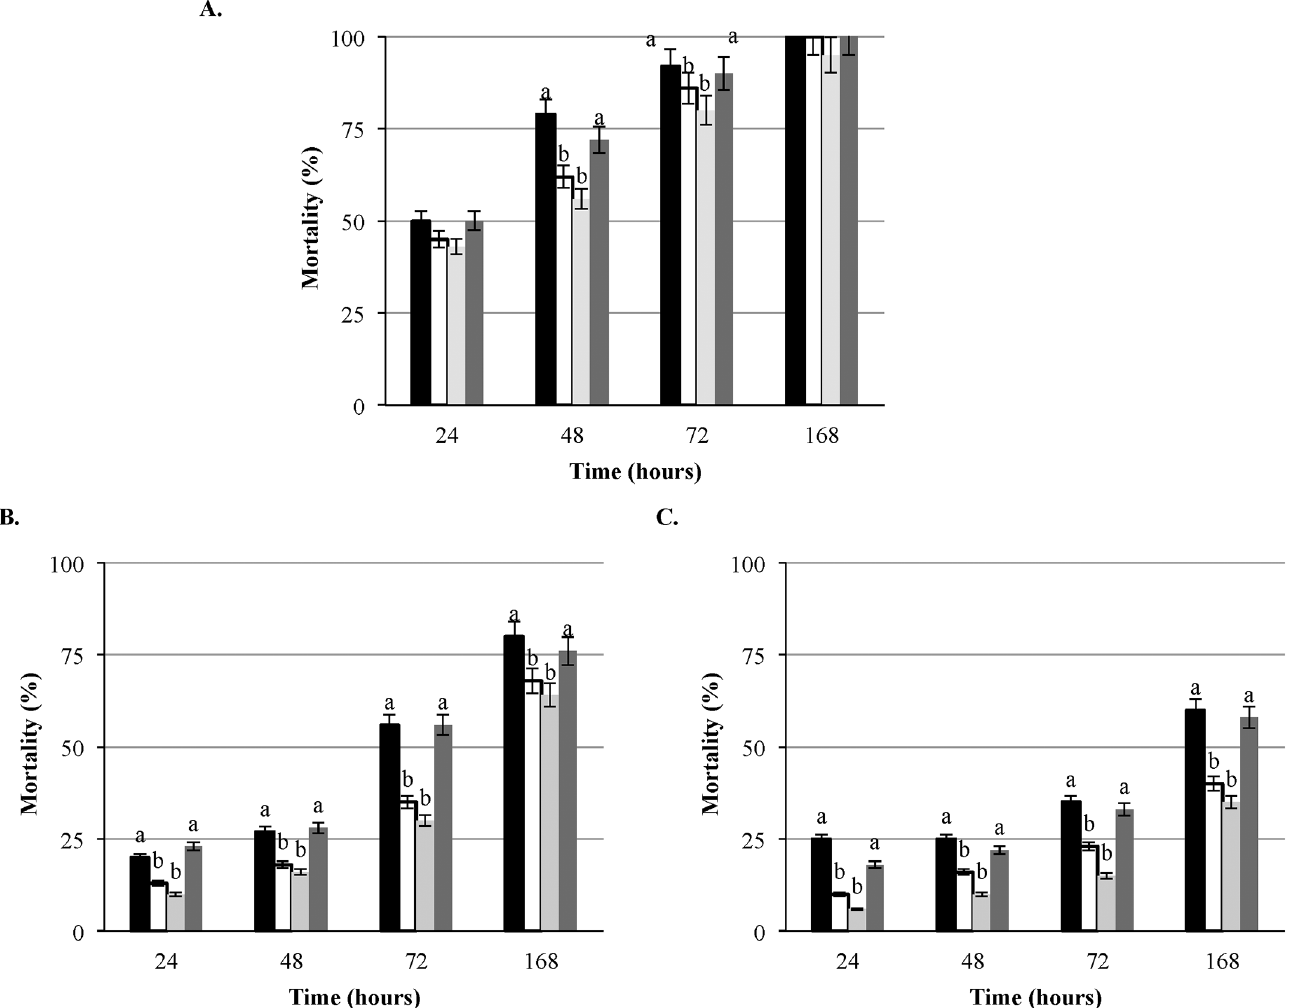
Fig 3. L . monocytogenes isogenic mutants with deletion in inlA , inlB and inlAB in Galleria . Mortality of larvaeinfected with the wild type L . monocytogenes strain LS1209(designated with black square) and isogenicmutants with deletionin inlB LS1214(designated with white square), inlAB LS 1215 (designatedwith light gray square) and inlA LS1222(designated with dark gray square) at the doses of (A) 10 6 CFU/larva (B) 10 5 CFU/larva, (C) 10 4 CFU/larva, a > b (P < 0.05). Presented results are averageof three independenttrials.